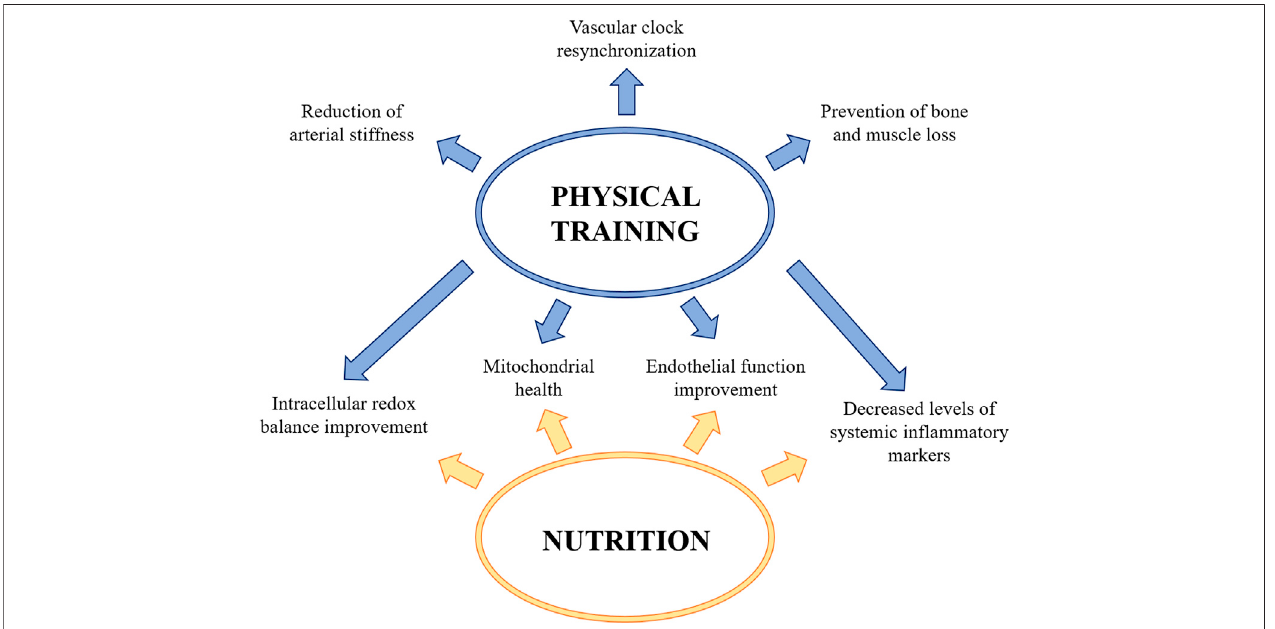
FIGURE 4 | Countermeasures to protect vascular function during space fl ight and prevent post- fl ight orthostatic intolerance. Physical training and a correct and adequate nutrition improveintracellularredox balanceand mitochondrial health, reduce the levels ofsystemicin fl ammatorymarkers and ameliorate endothelialfunction. Physical training also contributes to the arterial stiffness reduction, to prevent the bone and muscle loss and to resynchronize vascular clock.